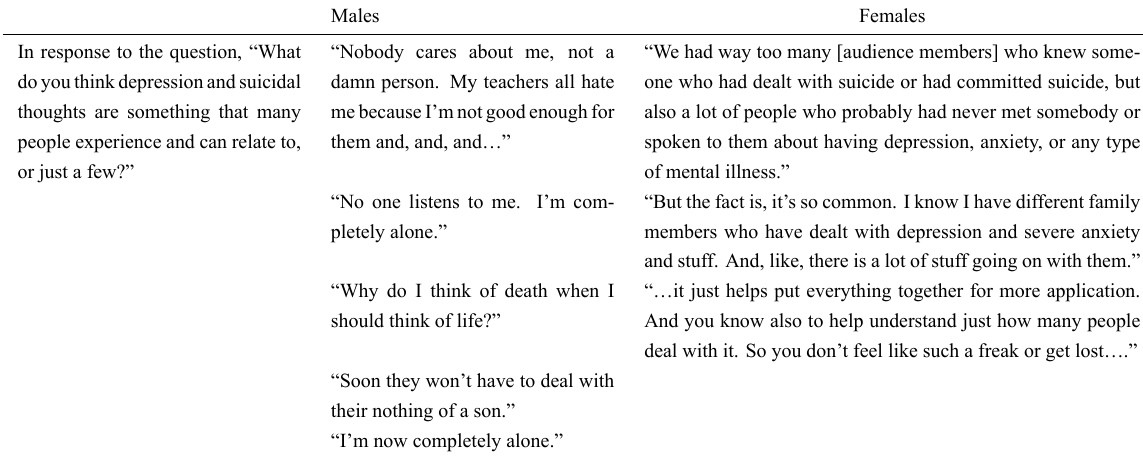
Table 4. Beliefs about individual vs. communal suffering. Males